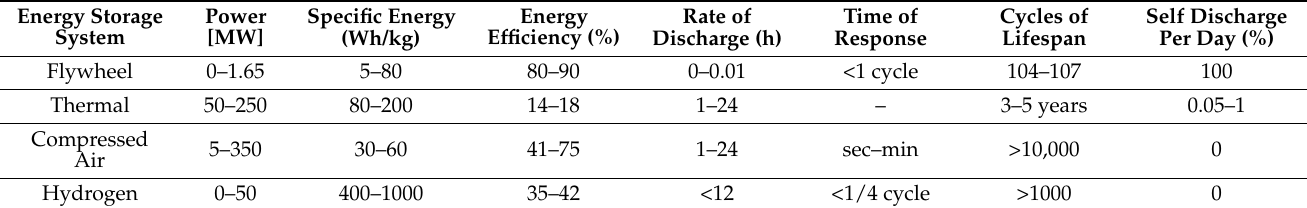
Table 5. Technical characteristics of energy storage systems